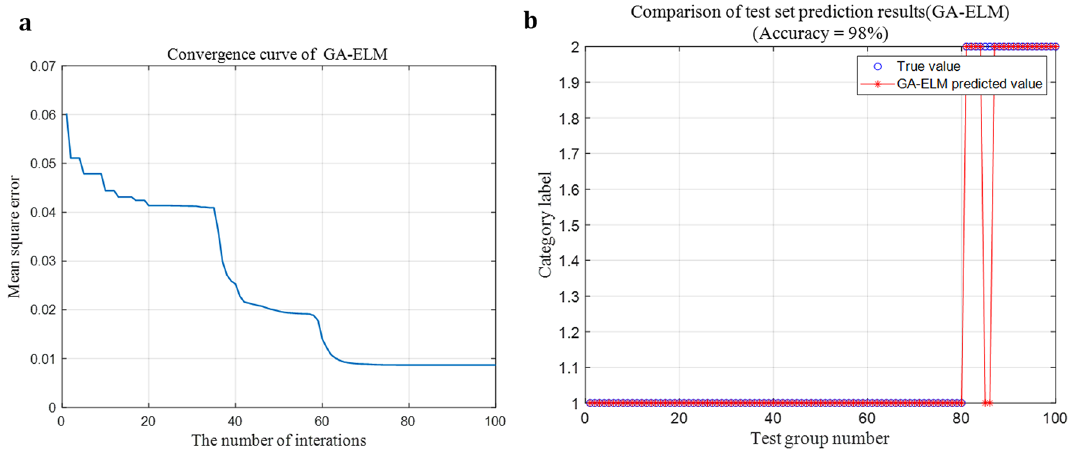
Figure 12. Fault diagnosis effect of GA-ELM. ( a ) Convergence curve of GA-ELM. ( b ) Fault diagnosis accuracy of GA-ELM.